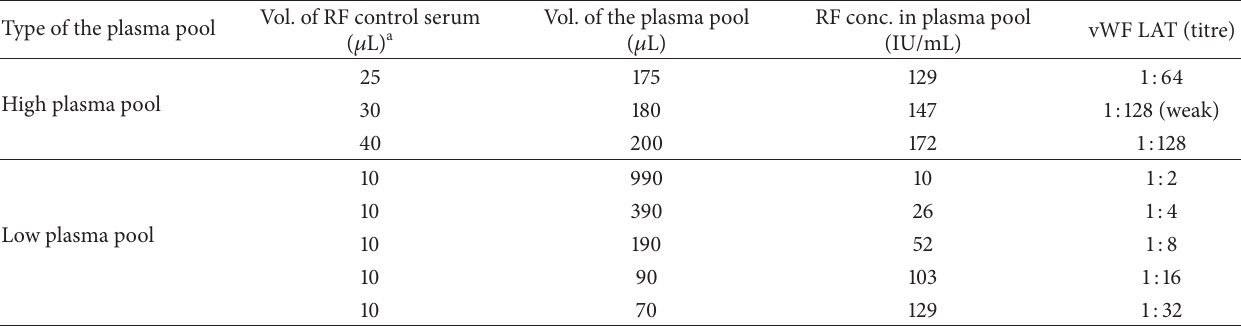
Table 5: Rheumatoid factor interference on high and low plasma pools. Type of the plasma pool